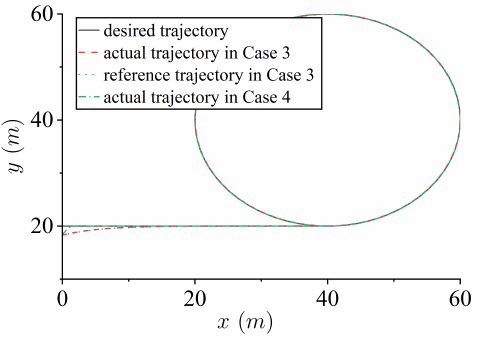
Figure 7. The comparison of trajectories in Case 3 and Case 4.